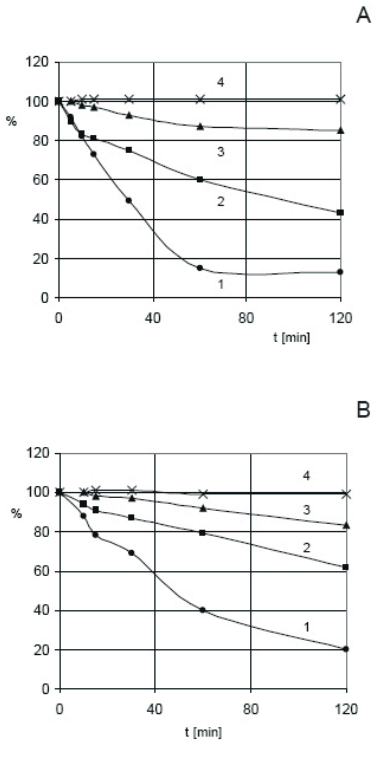
Figure 3. Time stability of DHCHE solutions containing 2.4 µg mL -1 DHCHE in 4% aqueous methanol (A) and in 4% aqueous ethanol (B) measured at 274 nm. Curve 1 – 0.01 mol L -1 HCl (pH = 2); 2 – formiate buffer (pH = 2.8), 3 – acetate buffer (pH = 4.2); 4 – phosphate buffer (pH = 6.7)